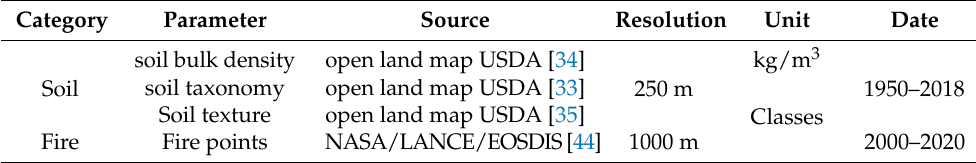
Table 1. List and description of the study’s datasets with source